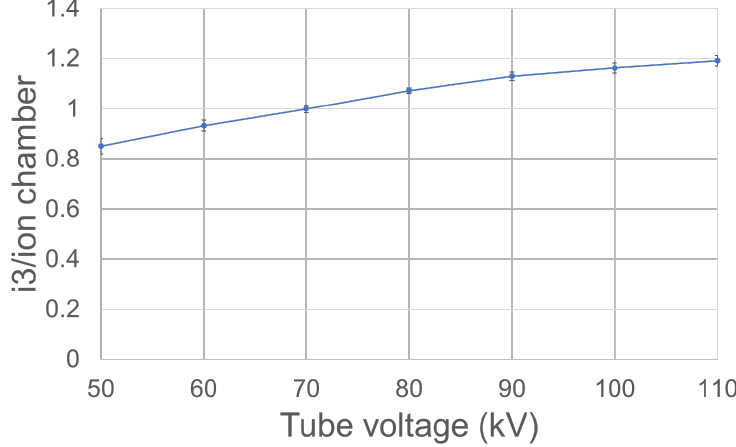
Figure 5. Tube-voltage dependencies of the i3 system (vertical axis: i3 measurements/ionization chamber measurements; horizontal axis: tube voltage).